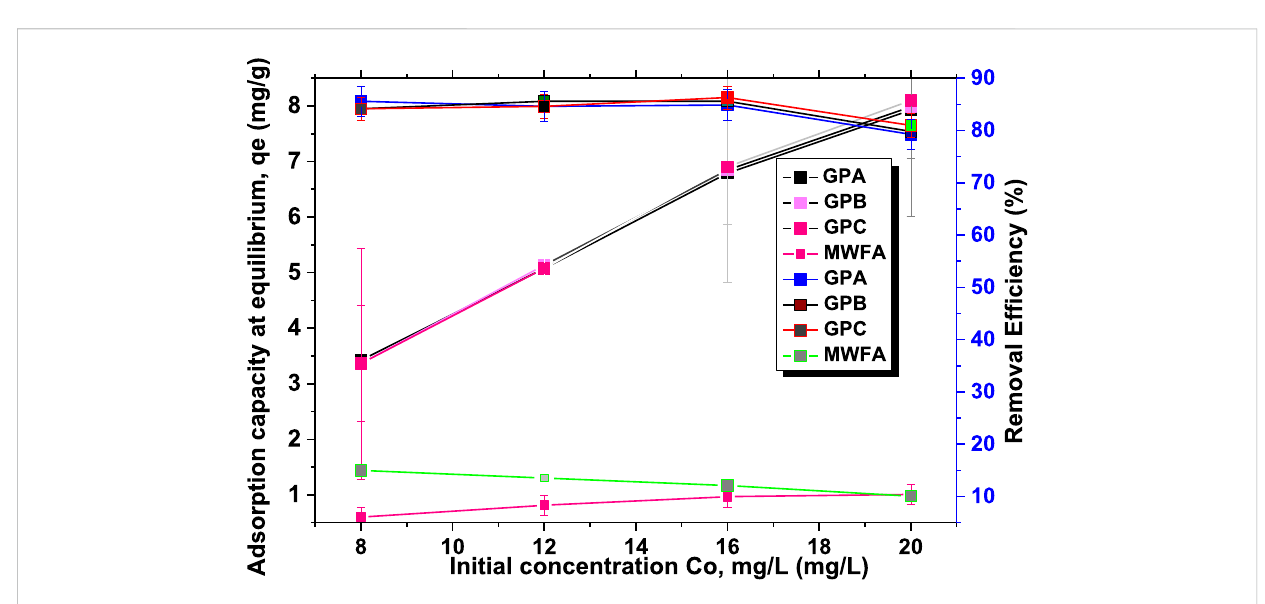
FIGURE 6 Effect of the initial concentration on the adsorption capacity and removal ef fi